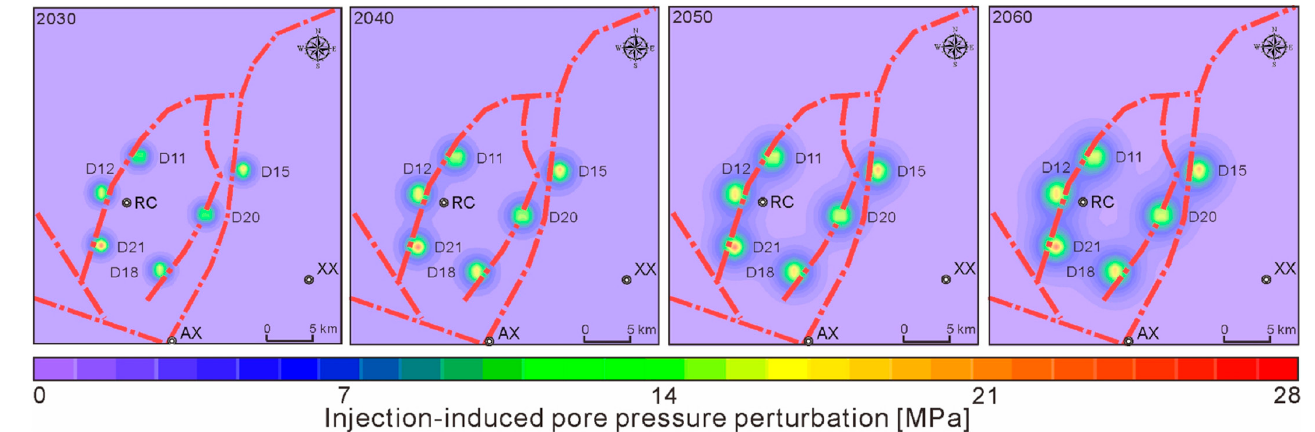
Figure 7. Map view of the excess pore pressure perturbations at a reference depth of 2600 m in 2030, 2040, 2050, and 2060.